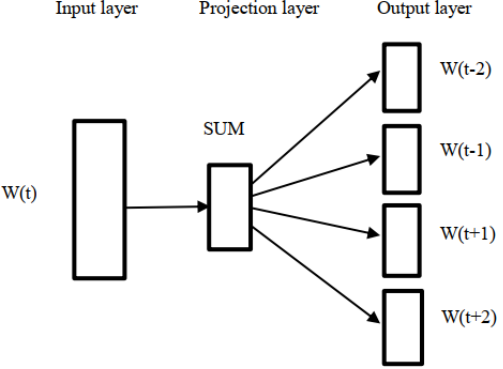
Figure 2. Skip-gram